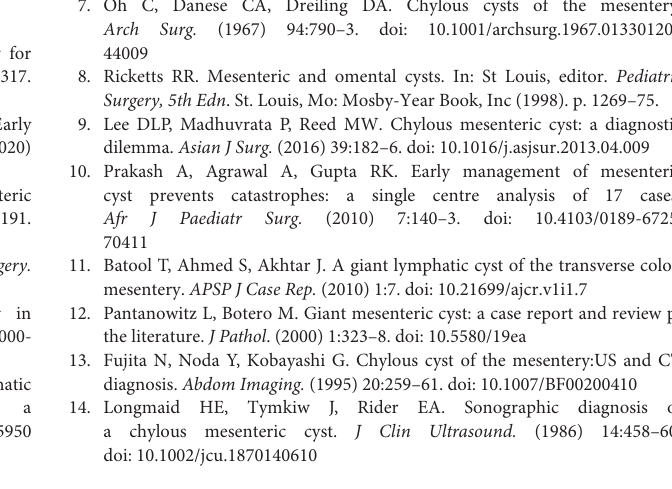
(lymphangioma containing chylous) and chyle-filled lymphatic cysts (a dilated lymphatic developing due to an obstruction of the lymph flow) (5). It has been also reported that malignant transformation may occur in 3% of cases (9, 12). Clinical and radiological findings are usually non-specific. Simple